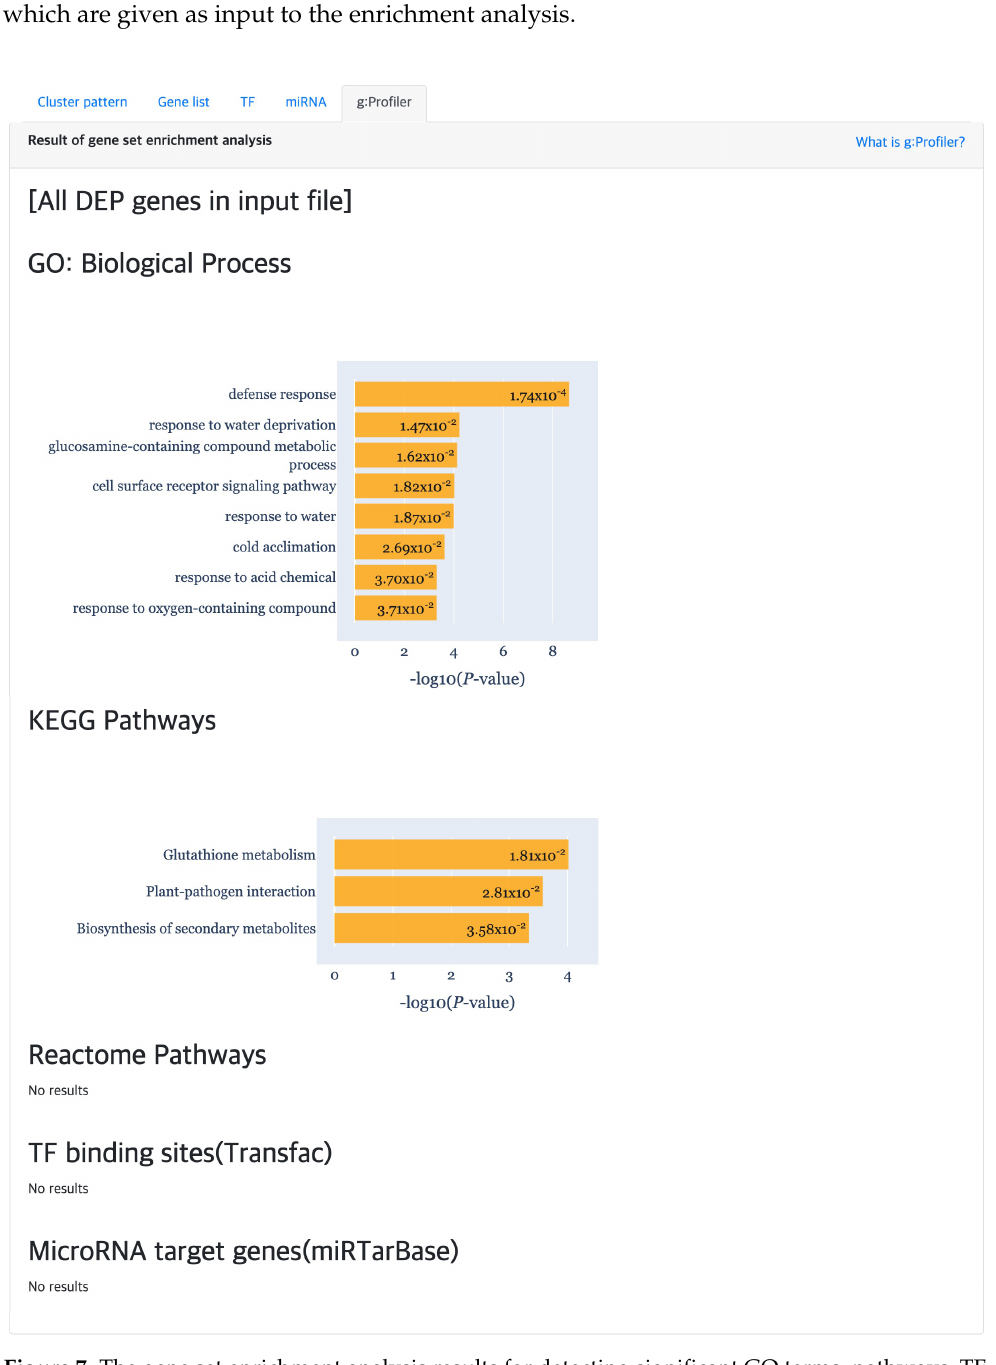
Figure 7. The gene set enrichment analysis results for detecting significant GO terms, pathways, TF binding sites and miRNA target using